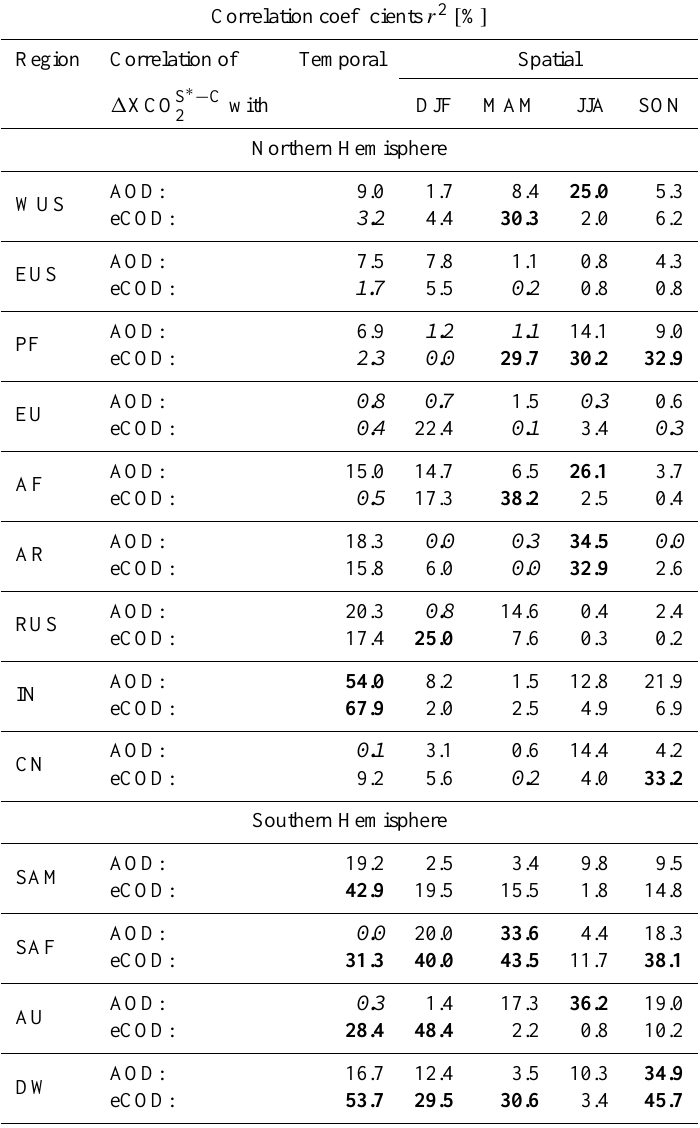
Table 5. Results of the spatial and temporal correlation analysis of 1 XCO S cients are statistically non-significant. The coefficients, which indicate that aerosols or clouds can explain more than 25% of the variability ∗ − C of 1 XCO S , are shown in bold. The results shown are based on monthly 2